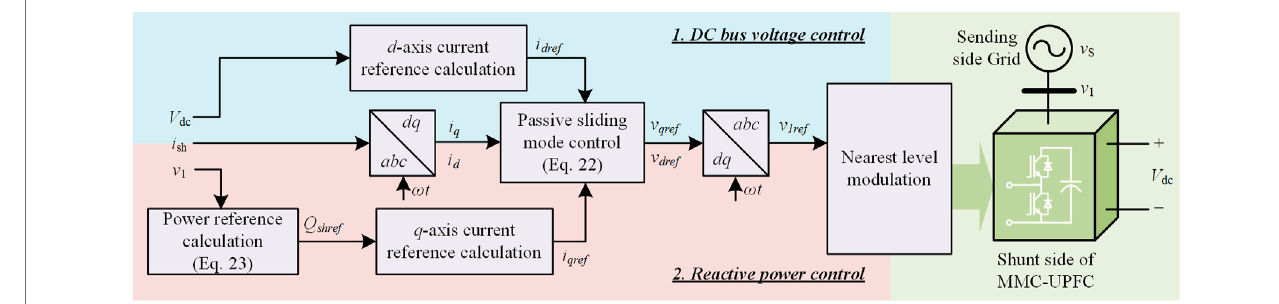
FIGURE 3 | General control diagram of the shunt side of MMC-UPFC.